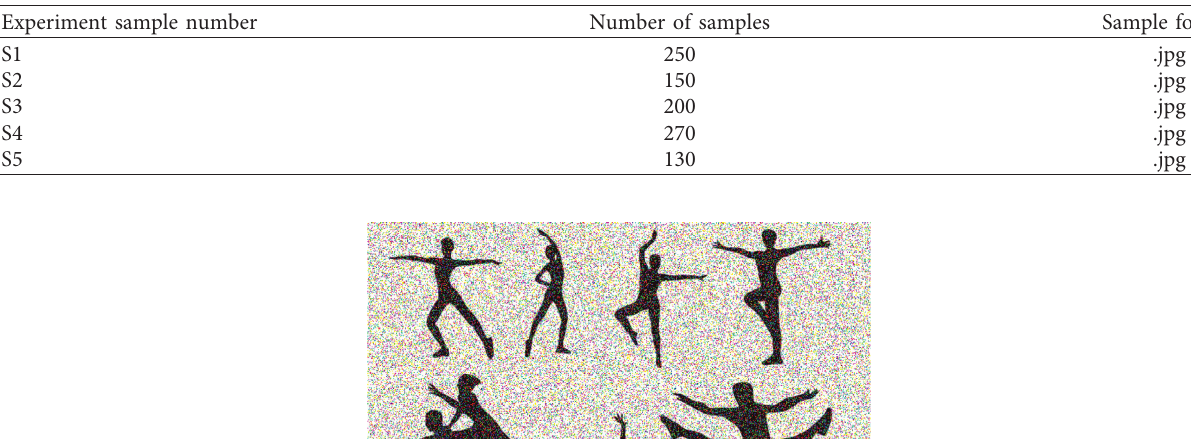
Table 1: Experimental data sample settings.